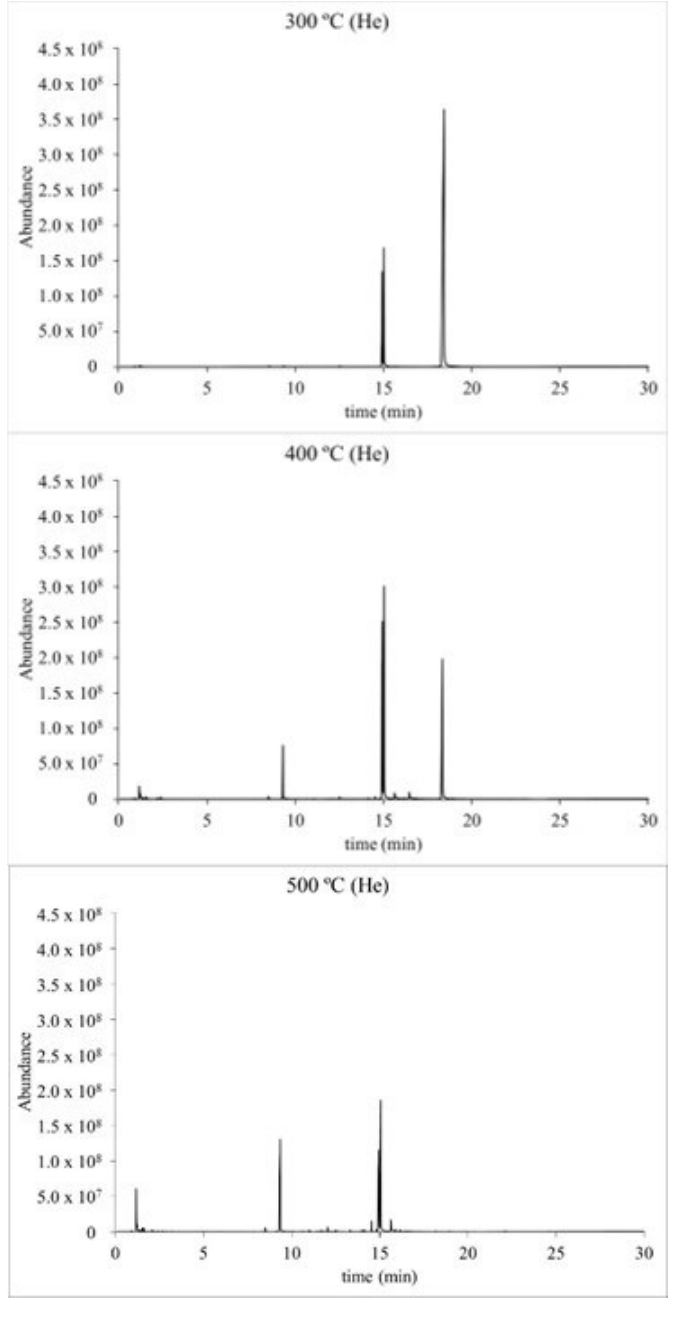
Figure 6. Chromatograms of the pyrolysis of NNN at different temperatures under the He atmos- phere.